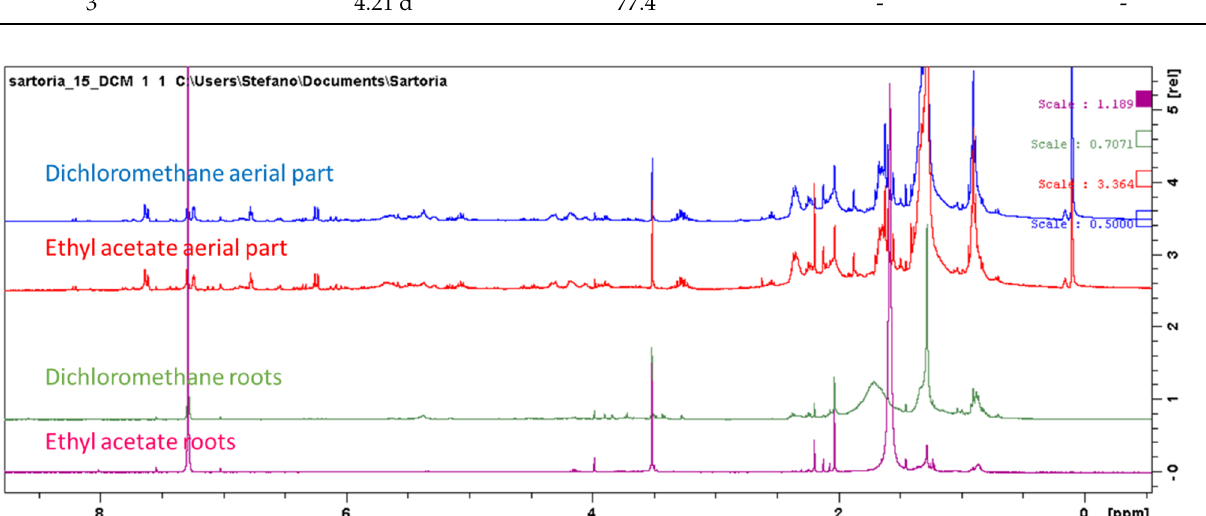
Figure 3. Superimposition of the 1 H-NMR spectra of lipophilic extracts of the aerial part and roots. Three main classes of compounds were detected. Identified phytocompounds could be grouped in phenolic and organic acids (comprising flavonoids and hydroxycinnamic and hydroxybenzoic acids derivatives), ellagic acid derivatives, and coumarins.